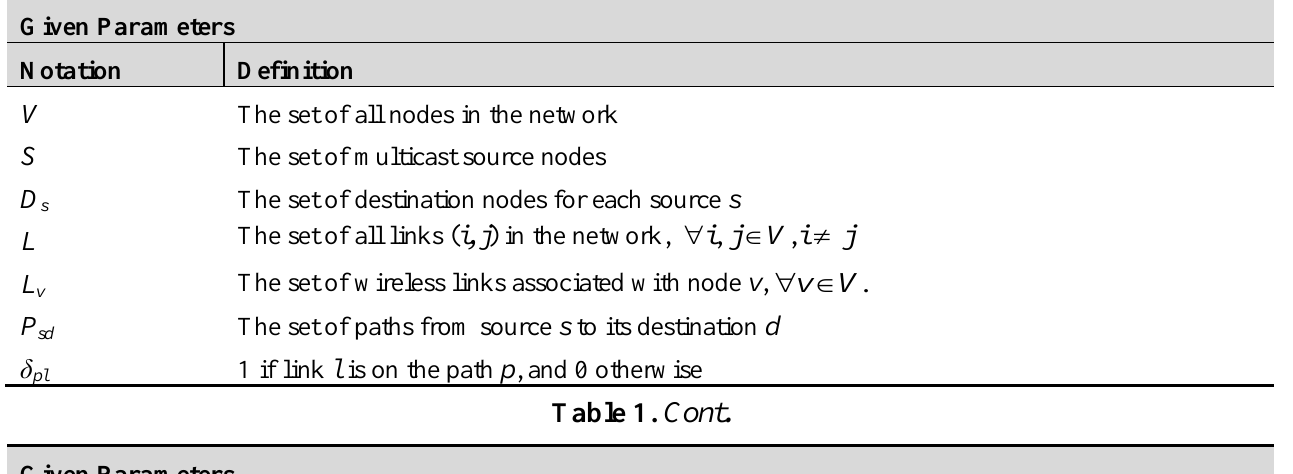
Table 1. Notation descriptions of given parameters.